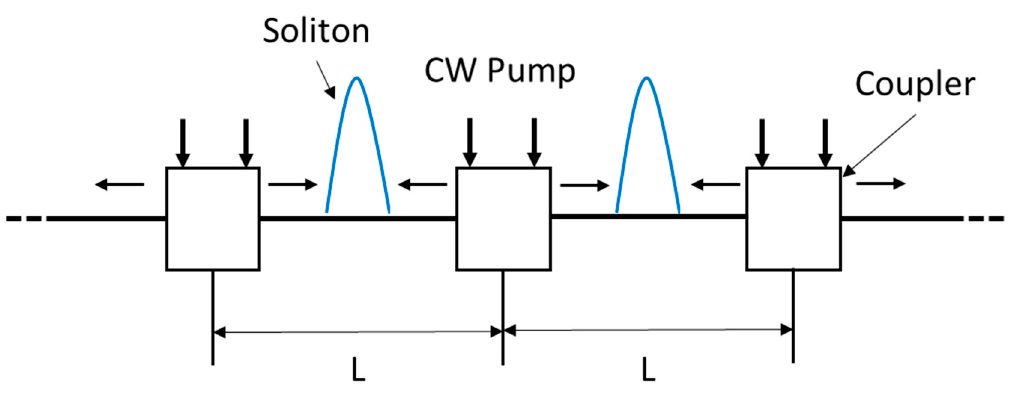
Figure 9. Schematic illustration of a soliton communication system. Solitons are amplified through SRS by injecting continuous wave (CW) pump radiation periodically.